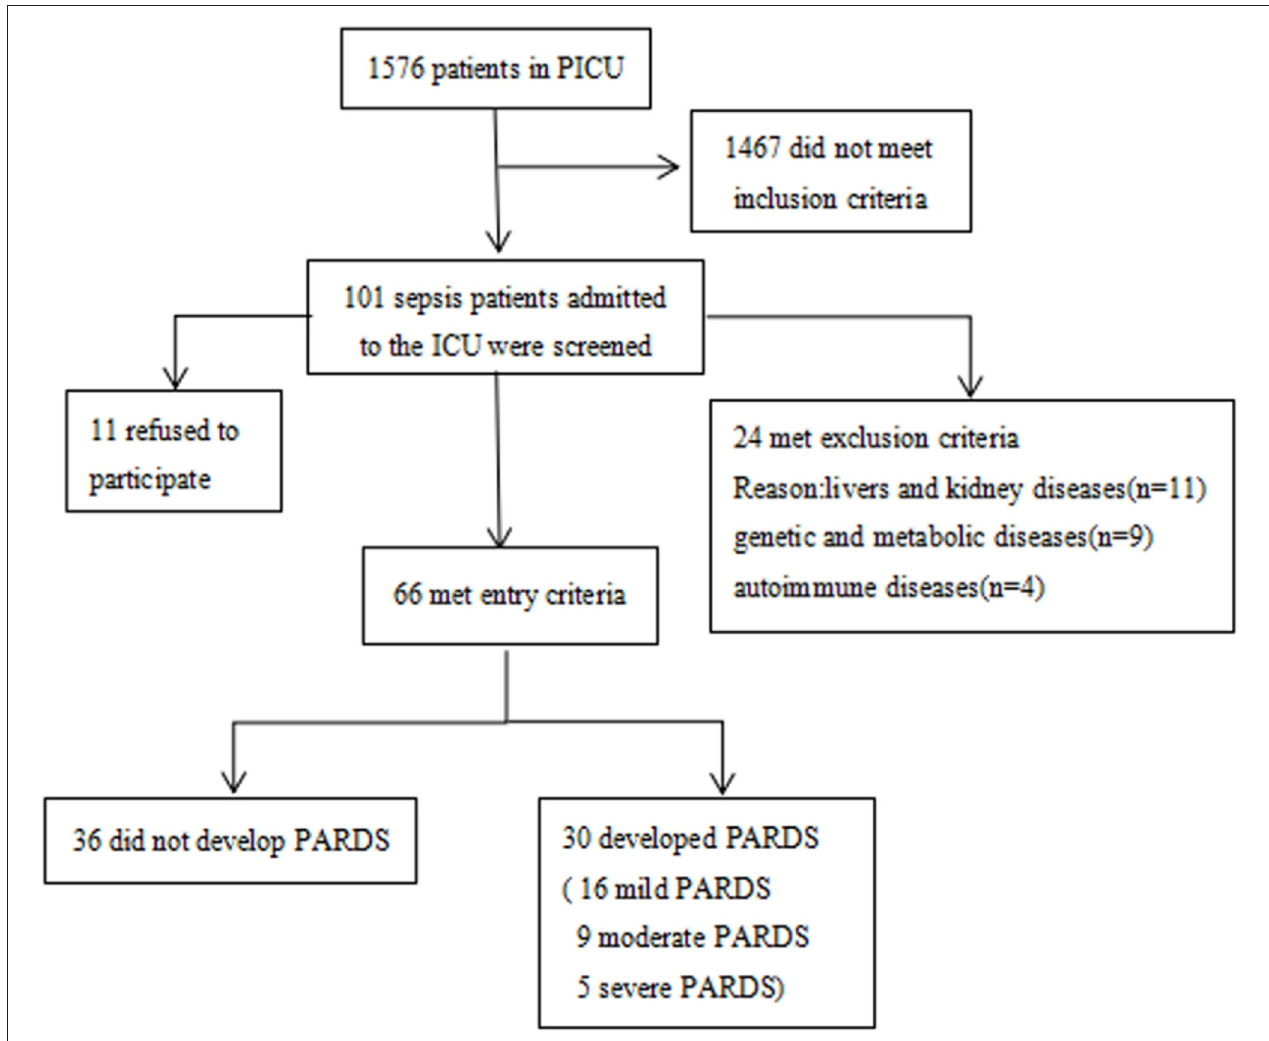
FIGURE 1 | Flowchart of all the patients included in this